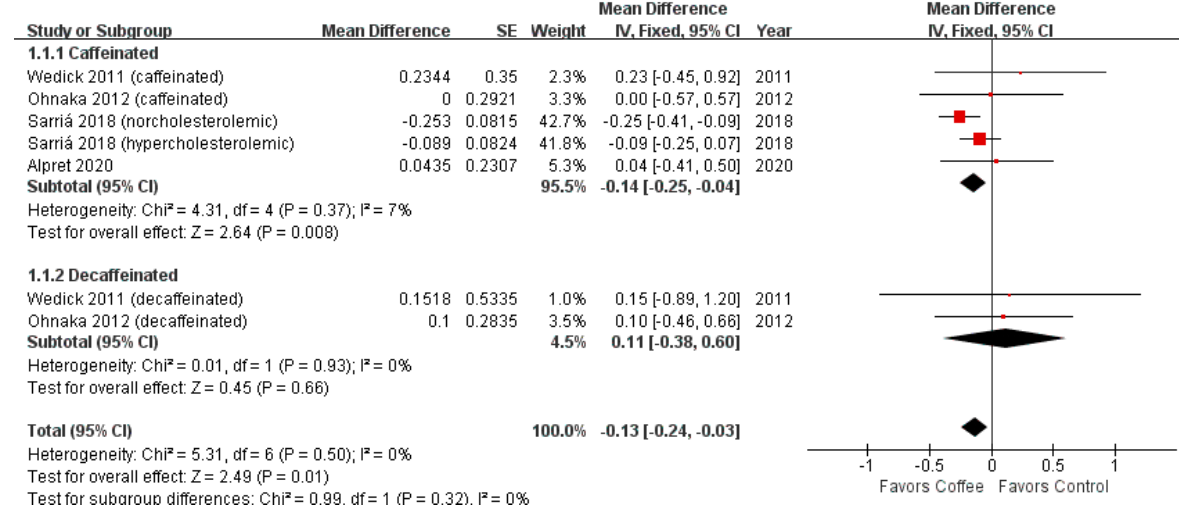
Figure 3. Effects of coffee on HOMA-IR.